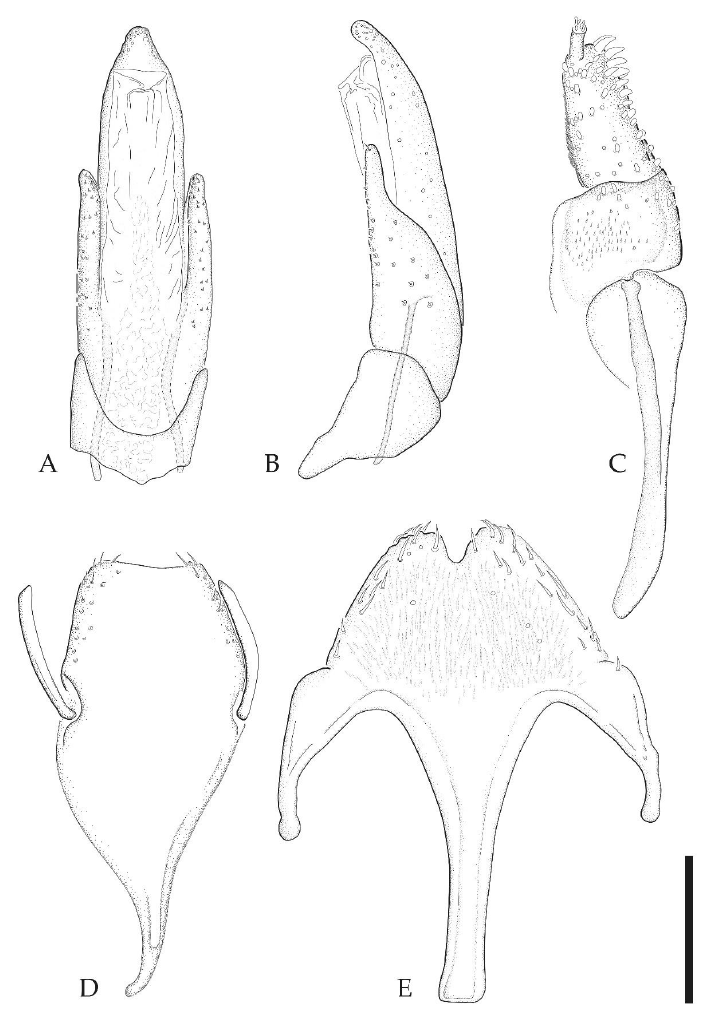
Figure 4. Vector illustrations of Ancyronyx jhoanae sp. nov.: ( A ) aedeagus, ventral view; ( B ); aedeagus, lateral view; ( C ) ovipositor; ( D ) male sternite IX; and ( E ) female sternite VIII. Scale bar = 100 μm. Aedeagus (Figure 4A,B) ca. 31 0 μm long; median lobe long, moderately slender, con- ical towards broadly subtriangular, rounded apex (Figure 4A), slightly curved ventrad (lateral view, Figure 4B), with pores most dense at apex; ventral sac plicate, weakly scle- rotized, not reaching apex (Figure 4A,B); fibula weakly sclerotized, inconspicuous; corona inconspicuous. Phallobase asymmetrical, longer ventrally (lateral view, Figure 4B), with